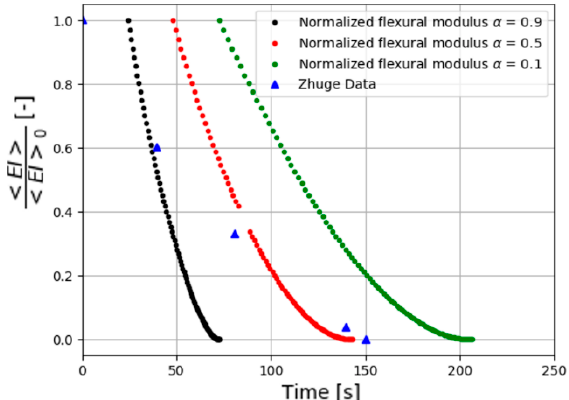
Figure 9. Normalized flexural modulus as a function of combustion time for an E-glass/polyester composite laminate and a heat flux of 50 kW/m 2 . Comparison between numerical simulation prediction (discontinuous curves) and experimental data ( ▲ ) obtained by Zhuge et al. [25].